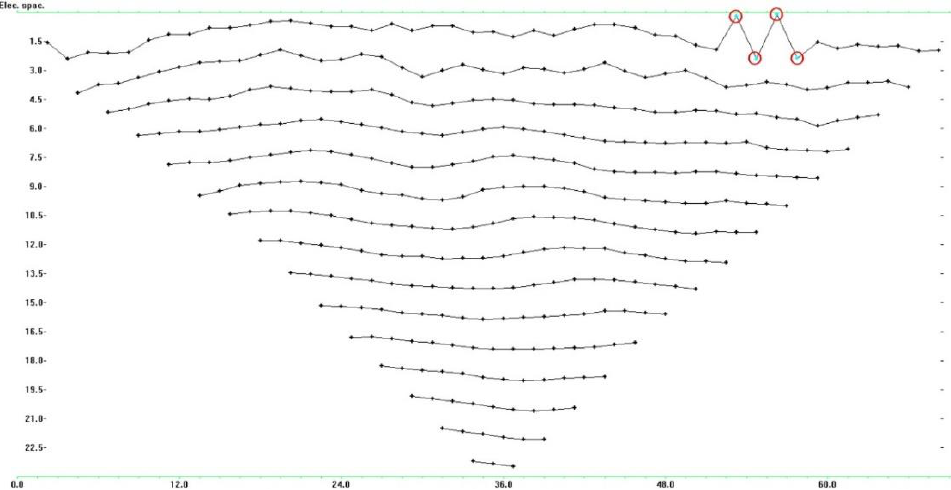
Figure 9. The distribution of bad data points (red circles) for the survey performed with the Wenner α array.